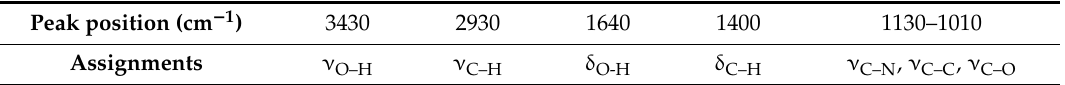
Table 2. Infrared bands and vibrational modes assigned to samples ZnS(1) and